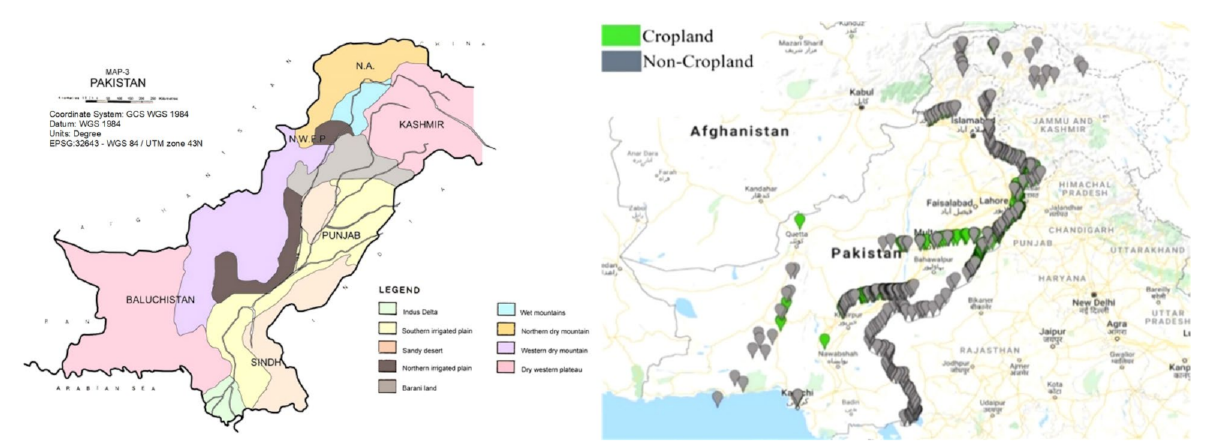
Figure 1. The division of the agro-ecological study into specialized subfields (RAEZs). The distribu- tion of comparative training data in machine learning algorithms is also shown in the illustration. Based on the pixel classification, the analyzed supervised areas